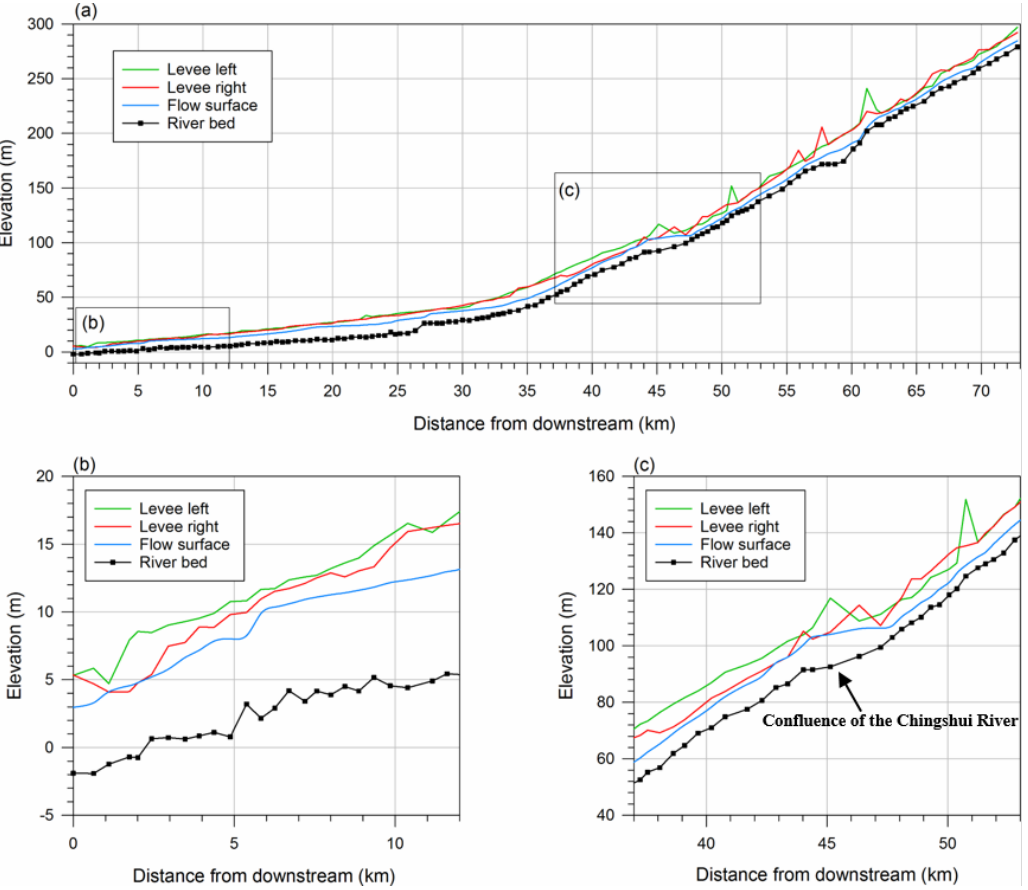
Figure 5. Simulation result of the most severe flood event at the end of the 21st century.